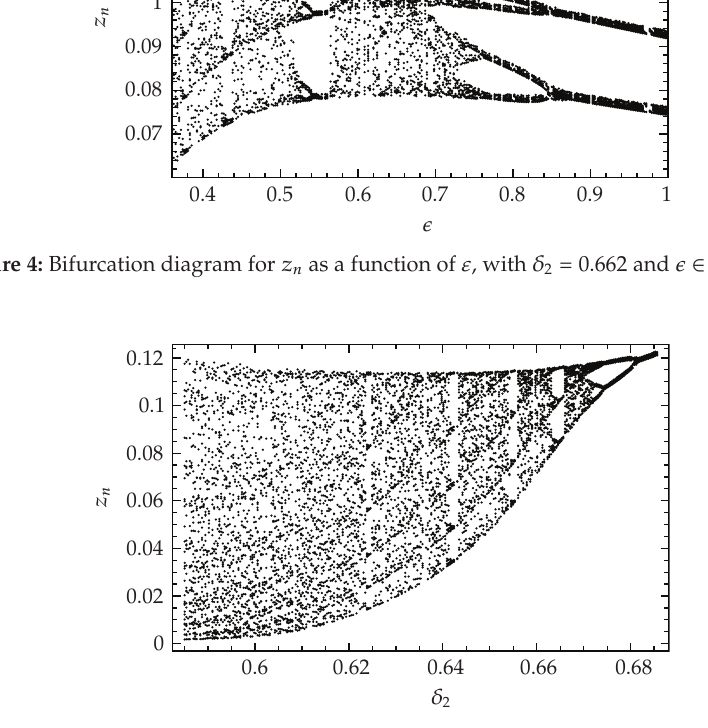
points defined by the Poincar´e map. The obtained iterated map dynamically behaves like a unimodal map (cid:3) family of continuous maps on the interval with two monotonic subintervals and one turning point (cid:4)